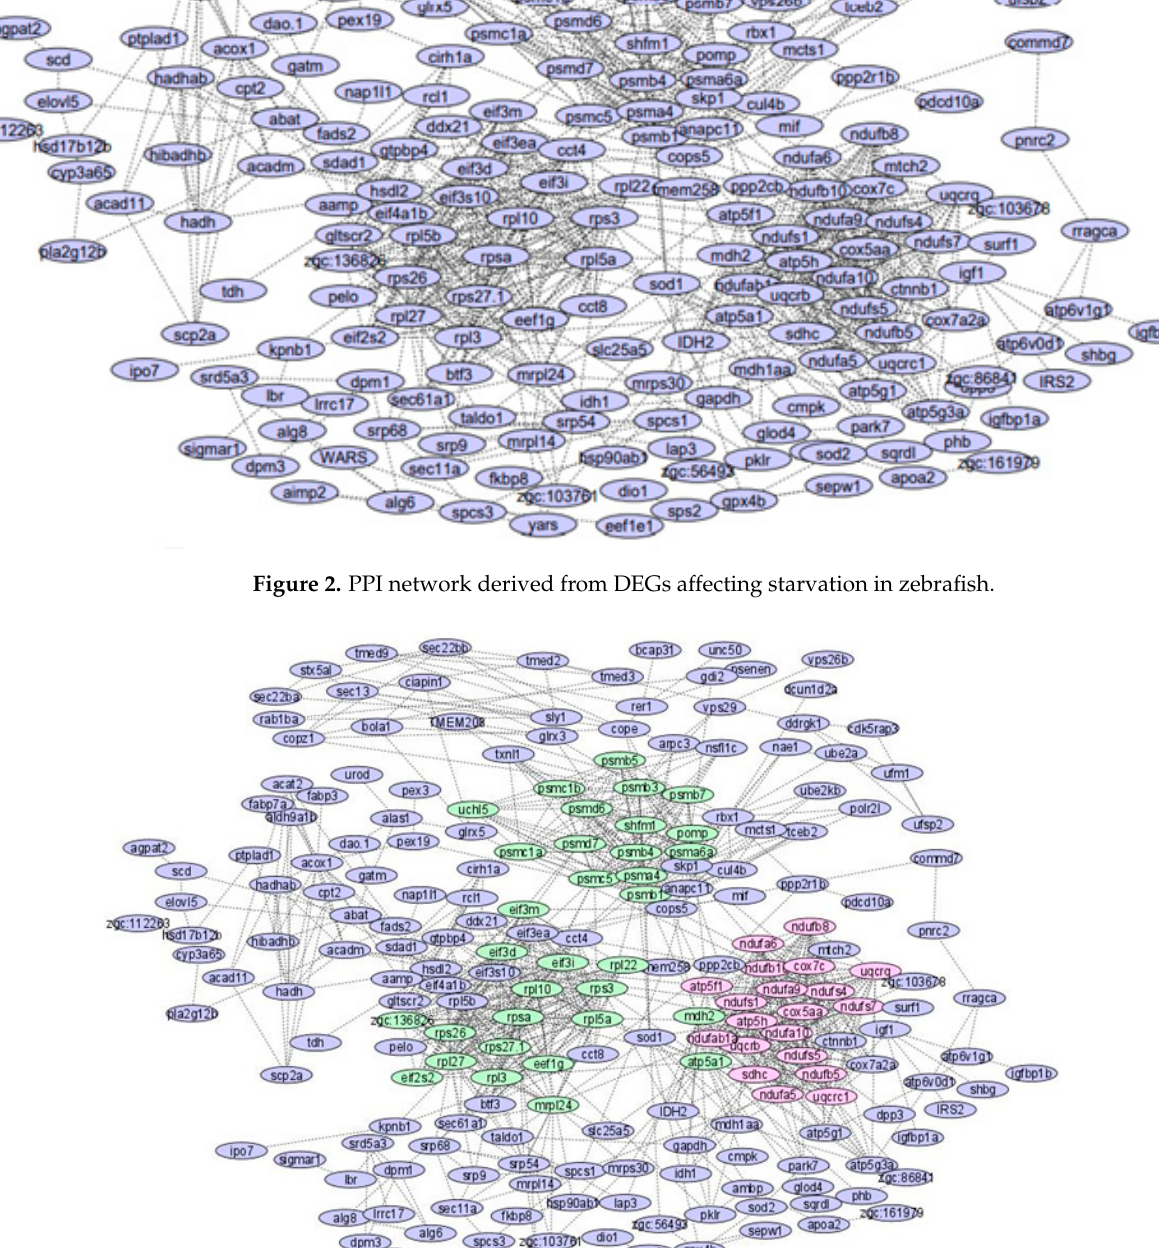
Figure 3. Two major modules of the PPI network (Module 1: green; Module 2: pink).